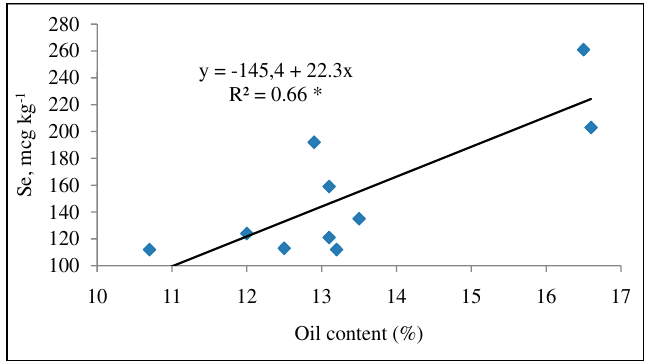
Fig.1 Fig. 1 - Relationship between selenium concentration and oil content in Allium cepa seeds (r = 0.82;